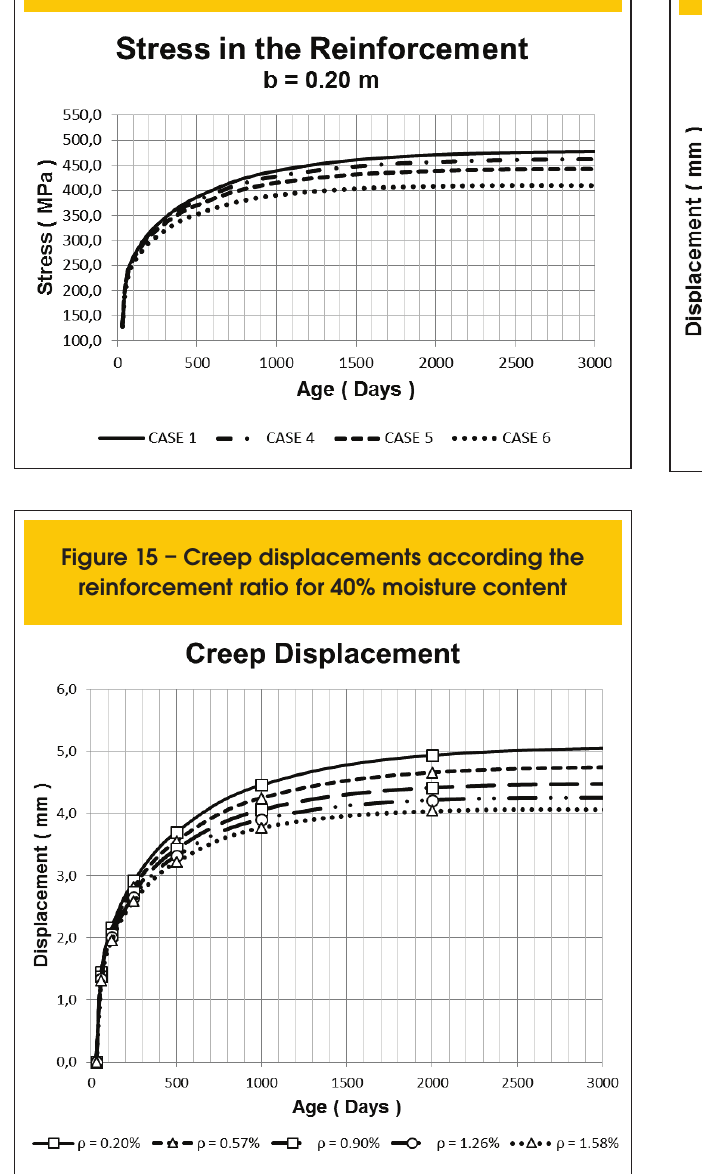
ratioFigure Figure 16 – Creep displacements according the environmental moisture for 0.40% reinforcement